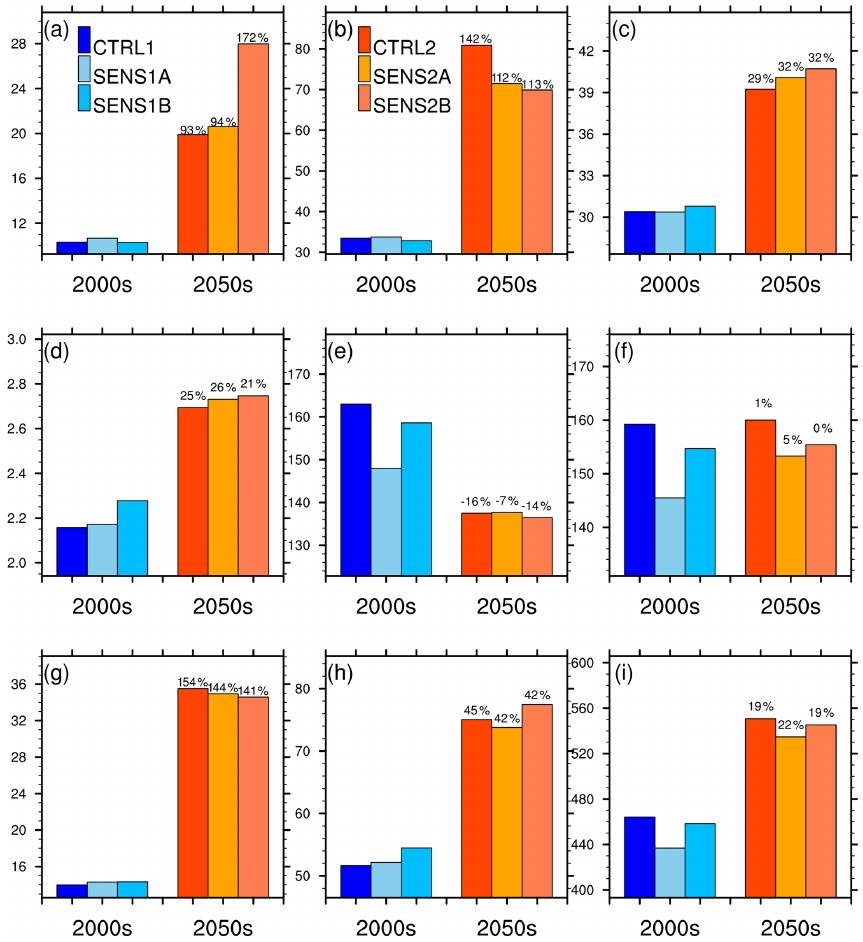
Figure 11. Comparison of annual burned area (Mhayr − 1 ) in each region among different time periods and sensitivity experiments. (a) North America; (b) South America; (c) Eurasia excluding the Middle East and South Asia; (d) the Middle East and North Africa; (e) Northern Hemisphere Africa; (f) Southern Hemisphere Africa; (g) South and Southeast Asia; (h) Oceania; (i) global total BA. The percentage numbers above the projection columns are changes in burned area in the 2050s relative to their counterpart experiments in the 2000s. The spatial distributions of these regions are shown in Fig. S4 of the